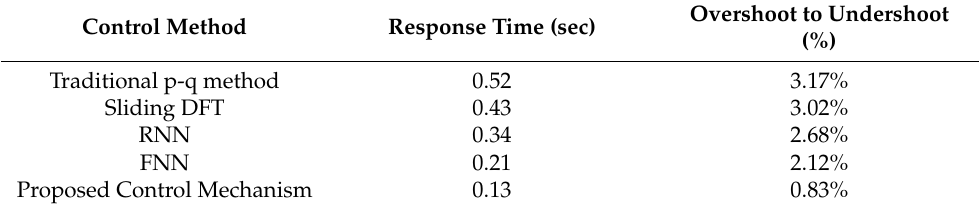
Figure 28. Regulation results of DC-link voltage. Table 5. Comparison for transient